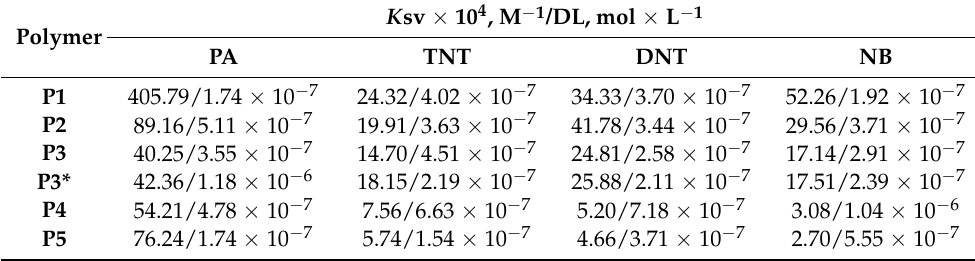
Table 4. Stern–Volmer constants and detection limits of nitroaromatics for fluorophores P1–P5 in CH 2 Cl 2